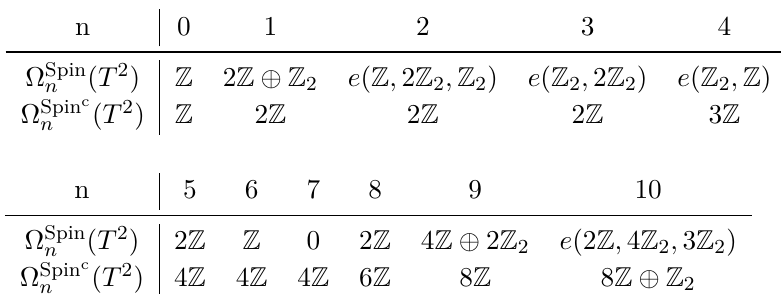
Table 10 . Cobordism groups Ω Spin